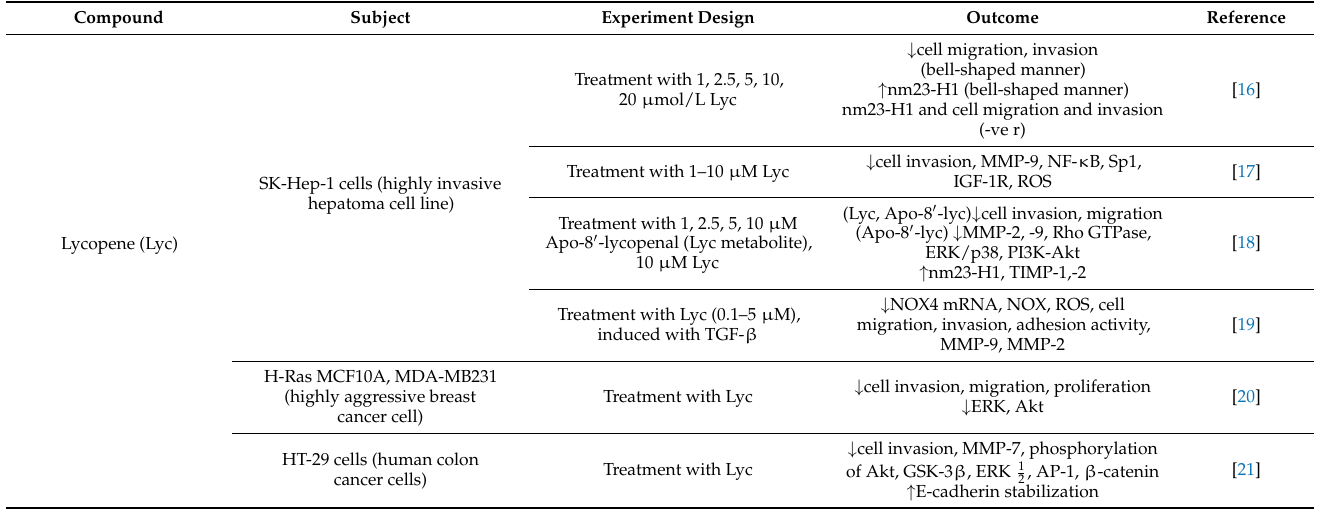
Table 1. Summary of cell culture studies evaluating anti-cancer properties of lycopene.